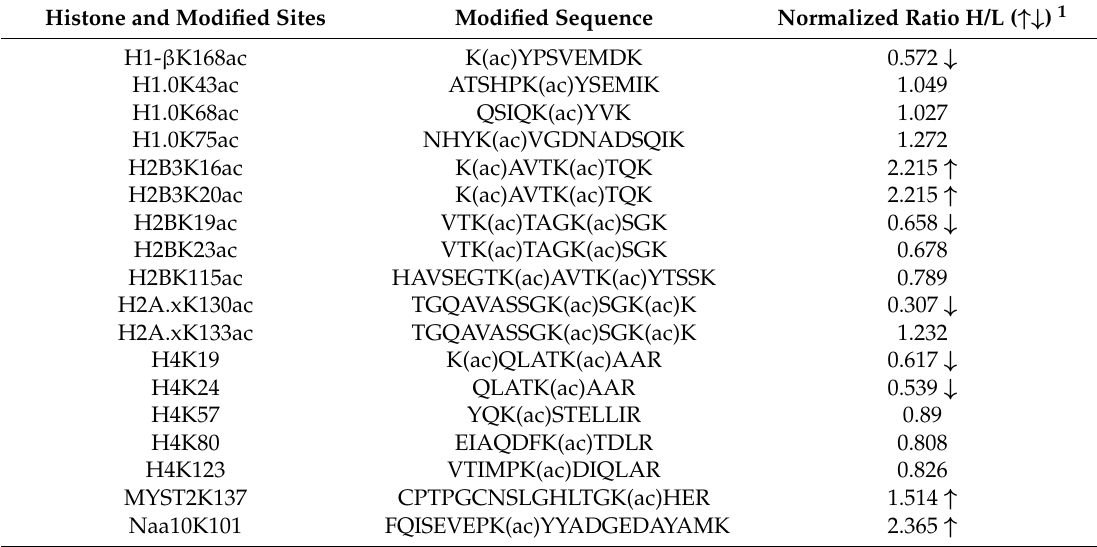
Table 1. Summary of quantifiable changes of lysine acetylation sites in histones and lysine acetyltransferases of CIK cells in response to GCRV